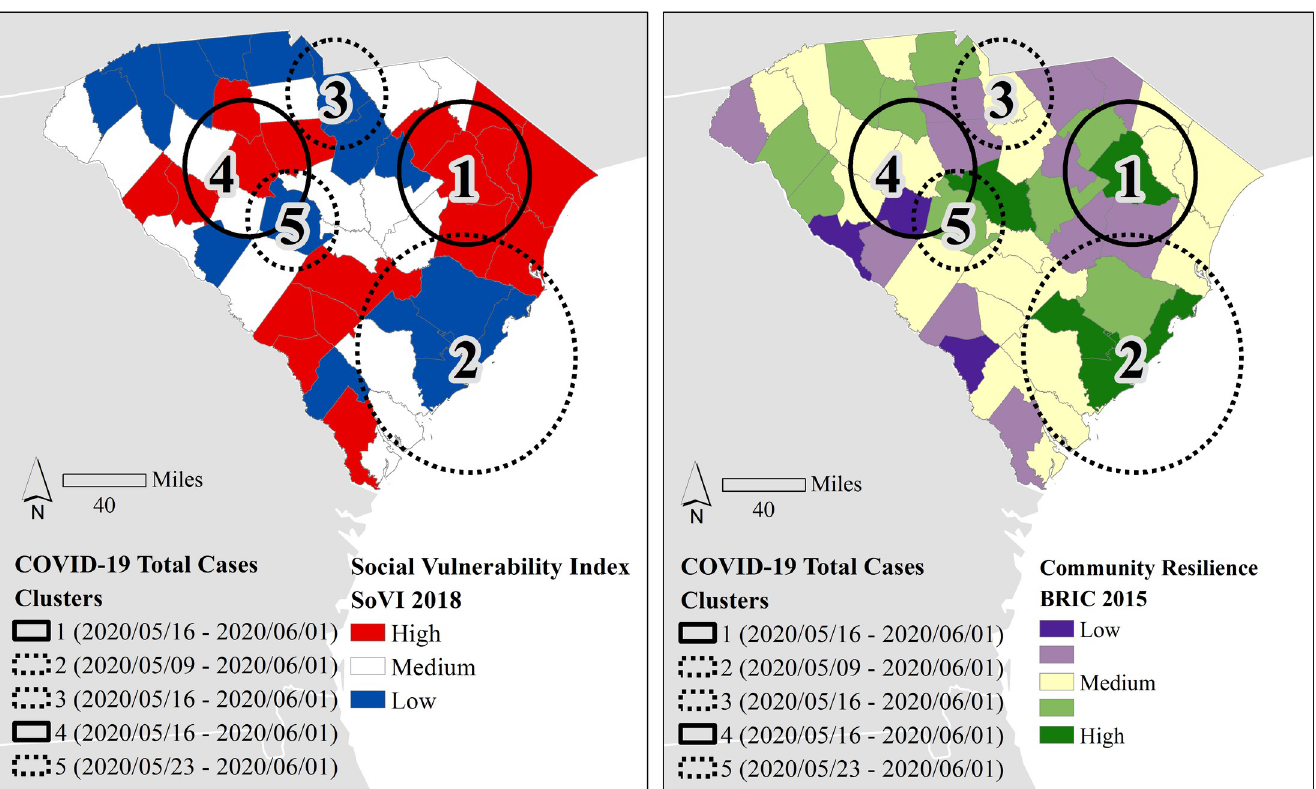
Fig 4. The results for the timeframe of space-time analysis clustering for total cases from the first case in March until Memorial Day, the unofficial beginning of summer (May 30). Using the county’s social vulnerability (left) and community resilience (right) as backdrops, high clusters are denoted by solid lines, while dashed lines refer to low clusters. All clusters are significant ( p < .001) except for cluster 5. County and state boundaries are retrieved from the U.S. Census Bureau (https://